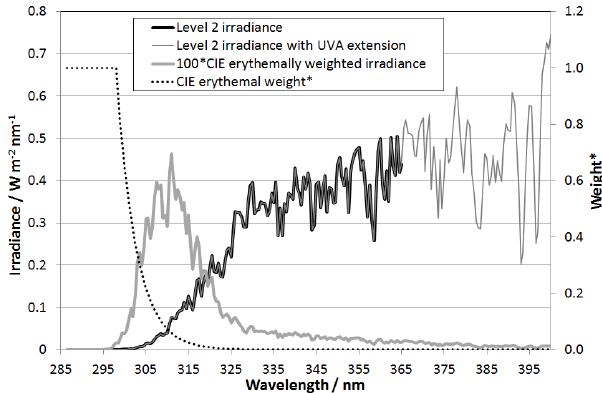
Figure 10. Example of the UVA extension to a spectrum and calcu- lation of the corresponding dose rate weighted with the CIE erythe- mal action